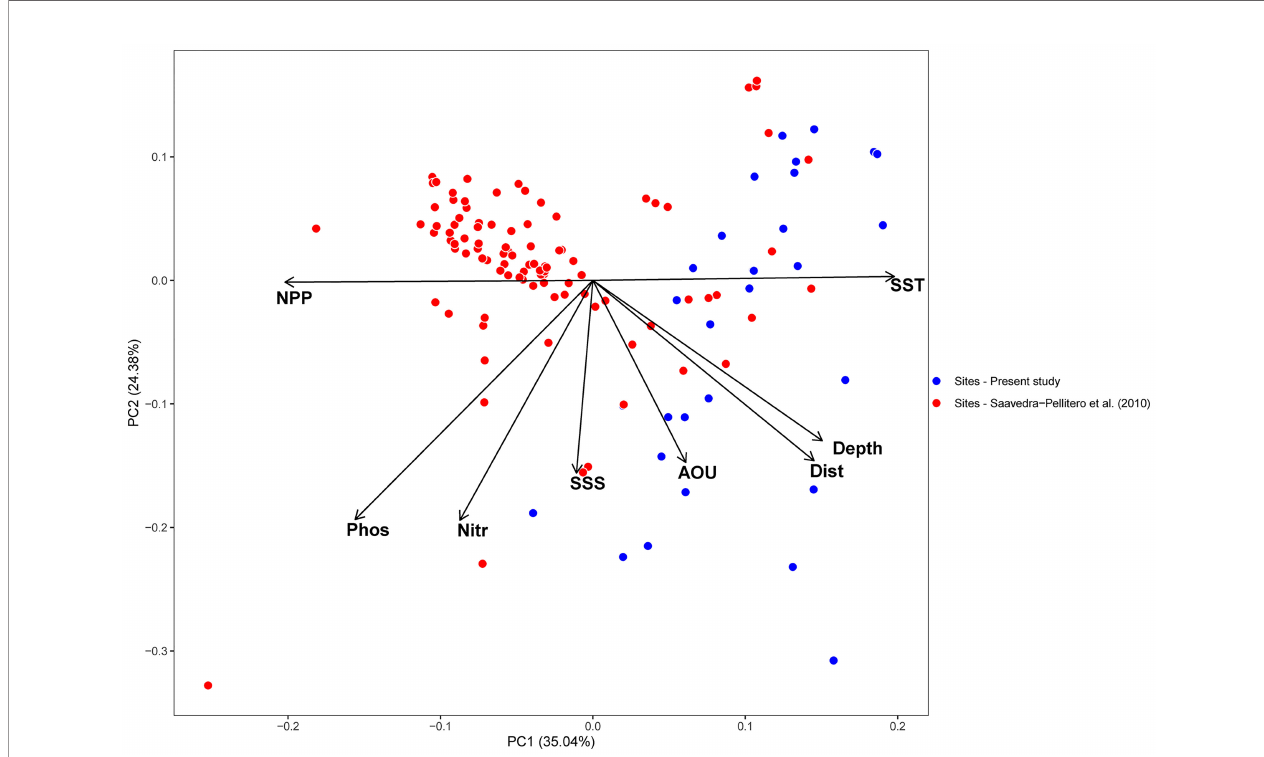
FIGURE 3 | Principal component analysis (PCA) of the environmental dataset. The red and blue dots correspond to the scores of the samples from Saavedra- Pellitero et al. (2010) and the present study, respectively. AOU=apparent oxygen utilization, Depth = sample depth, Dist. = distance to the coast, NPP = annual averaged Net Primary Productivity, Nitr = annual averaged nitrate content at 10 m water depth, Phos = annual averaged phosphate content at 10 m, SSS = annual averaged sea surface salinity at 10 m and SST = annual averaged sea surface temperature at 10